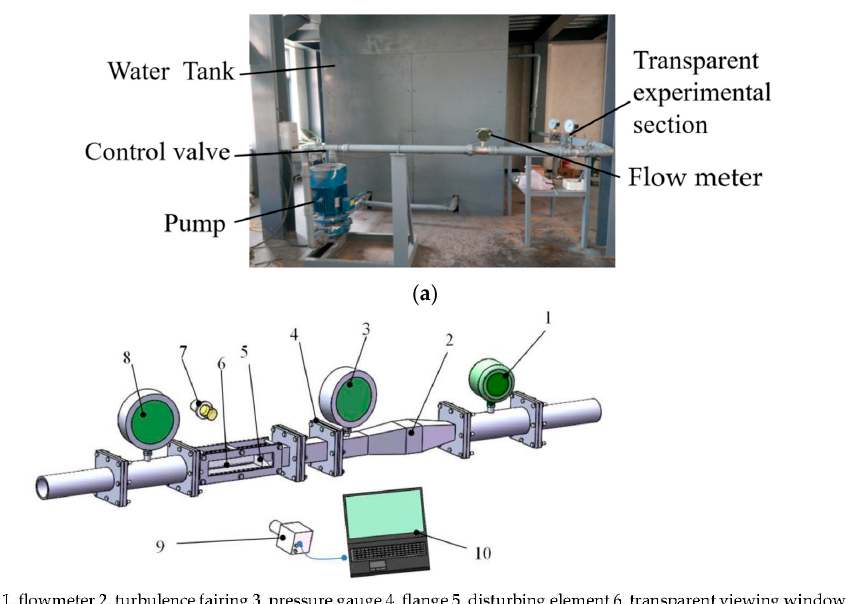
Figure 1. Experimental setup. ( a ) Water-cycling system. ( b ) Optical measurement part.